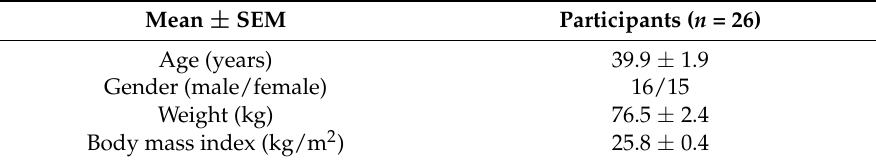
Table 1. Subject demographics in study 1.